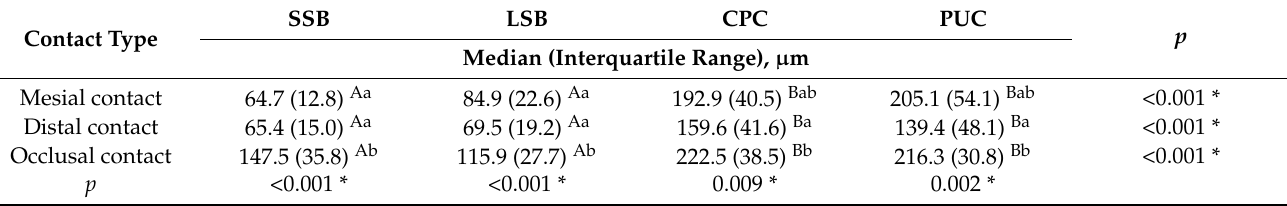
Table 1. Comparison of 3D displacements according to method of data capture.